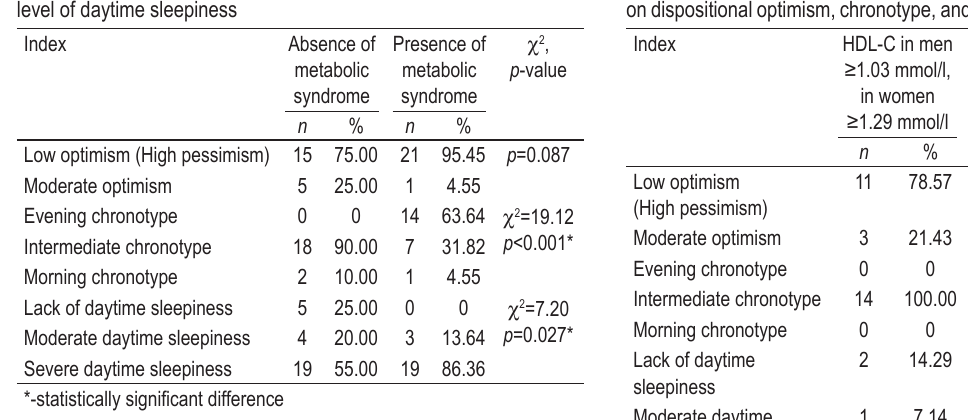
TABLE 2. Frequency of metabolic syndrome in patients with arterial hypertension, depending on dispositional optimism, chronotype, and